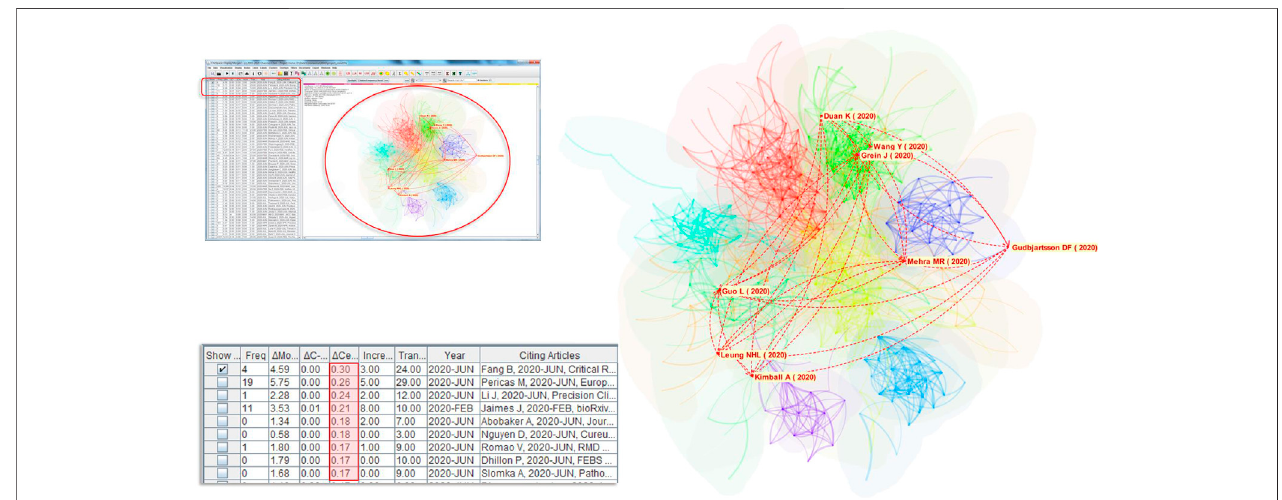
FIGURE 9 | An article identi fi ed by SVA with a high transformative potential according to centrality divergence.